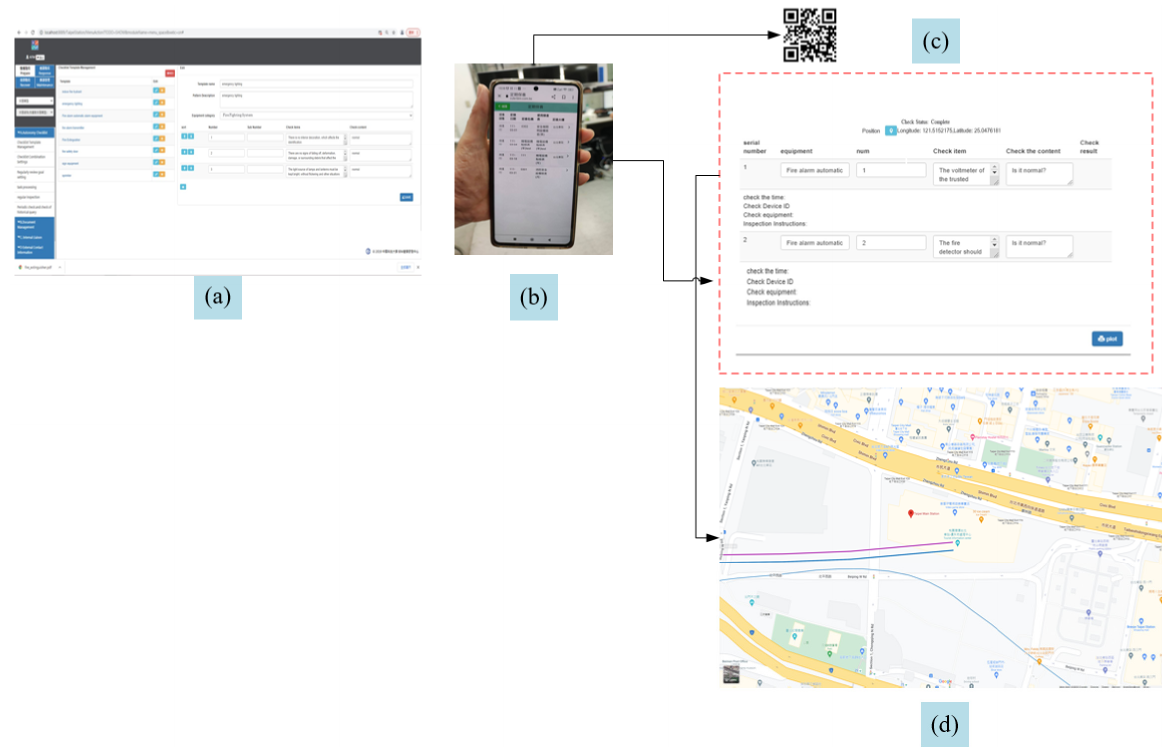
Figure 7. Pre-disaster (usual) preparedness: Equipment inspection. (Source: Research Data). (a) Inspection form; (b) APP; (c) QR Code; (d) Display equipment location.